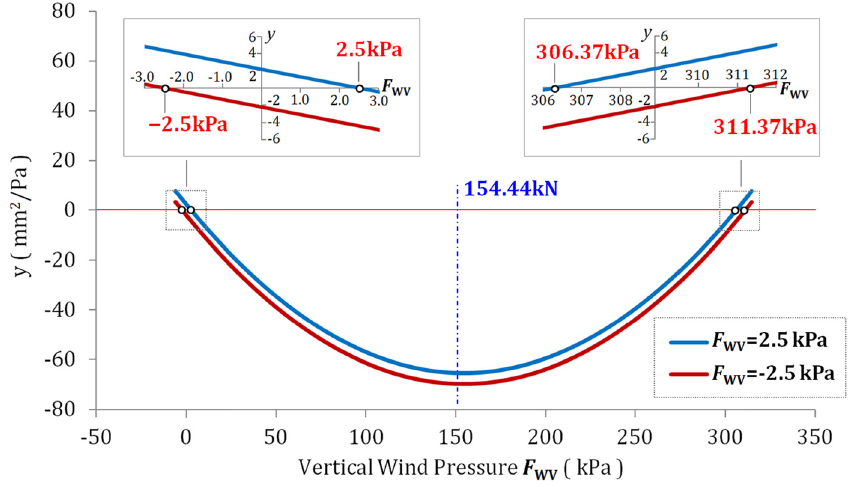
Figure 12: Root selection of vertical wind load identification.